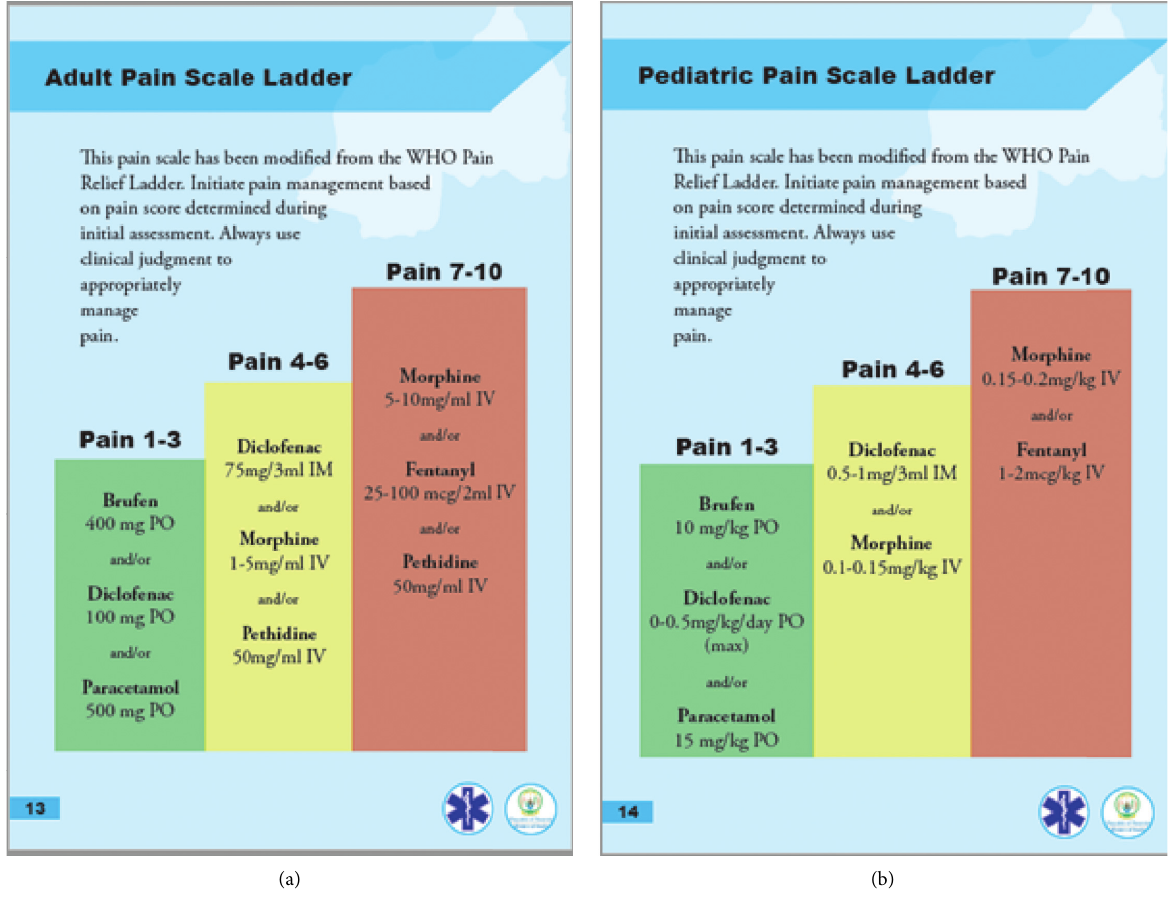
Figure 1: Adult and pediatric pain